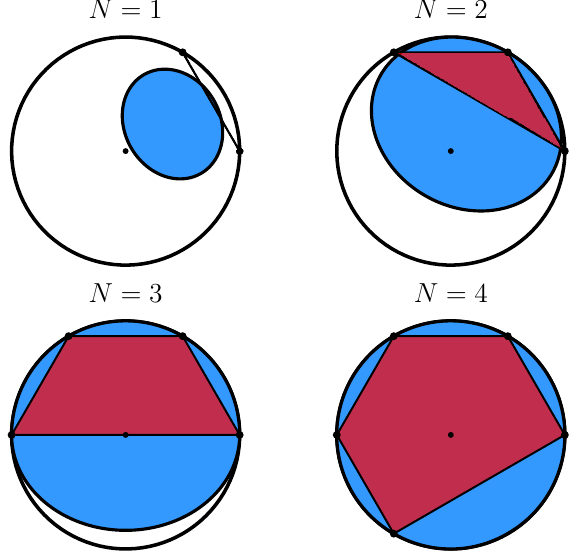
δ -numerical ranges W −